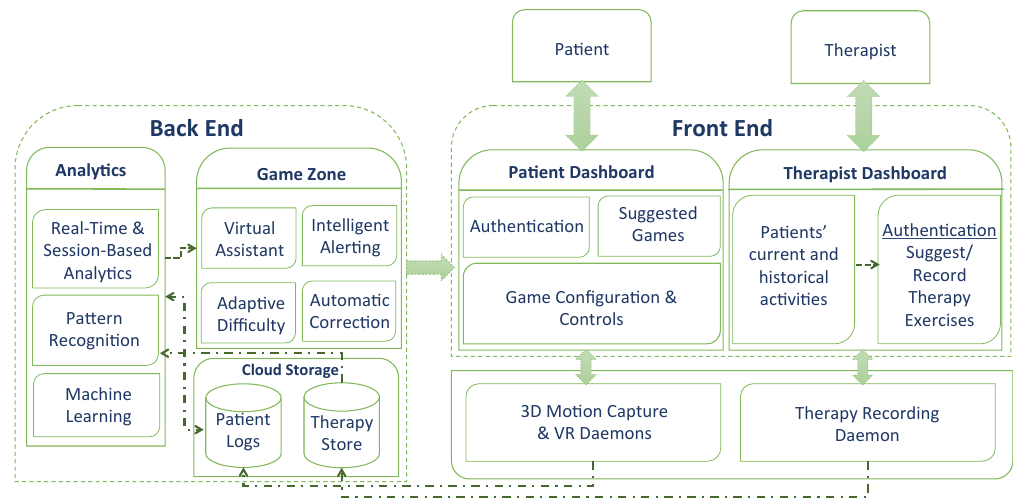
Figure 5. System architecture.